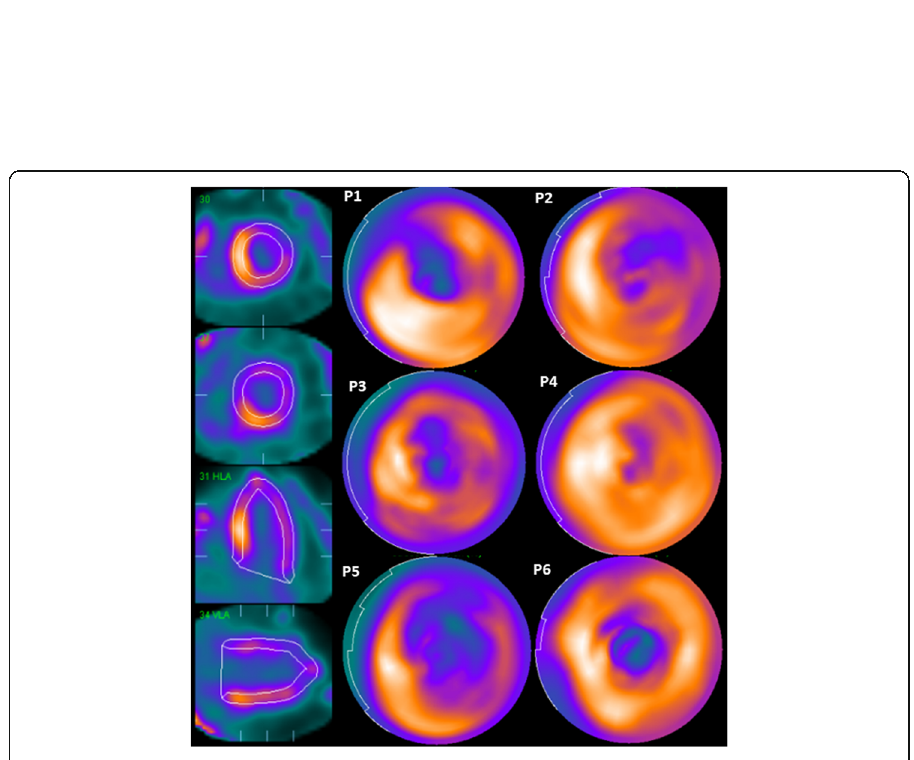
Fig. 2 Bullseye plots of HDP distribution in the LV myocardium of each of the patients with ATTR (P1-P6 in Table 1). The myocardial ROIs defined by the program for one patient are shown on the